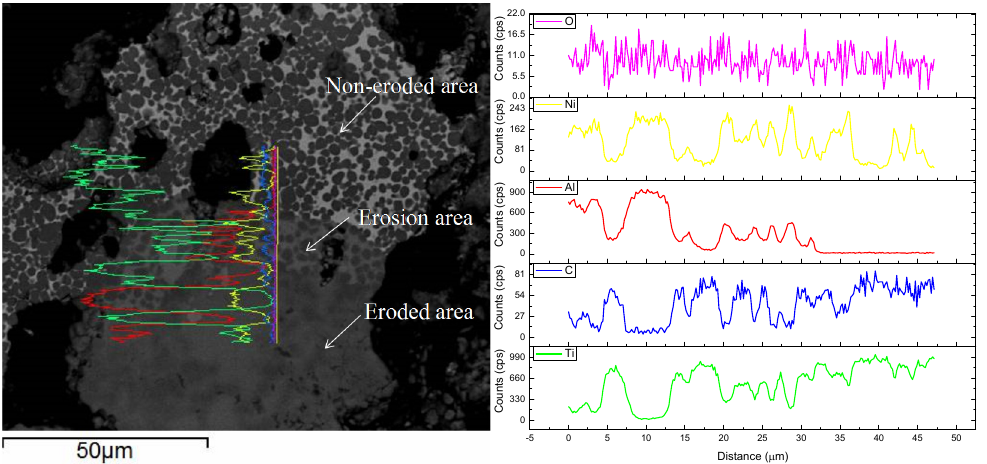
Figure 11. SEM and line scanning spectra of the cross section at the internal erosion front after the immersion test.